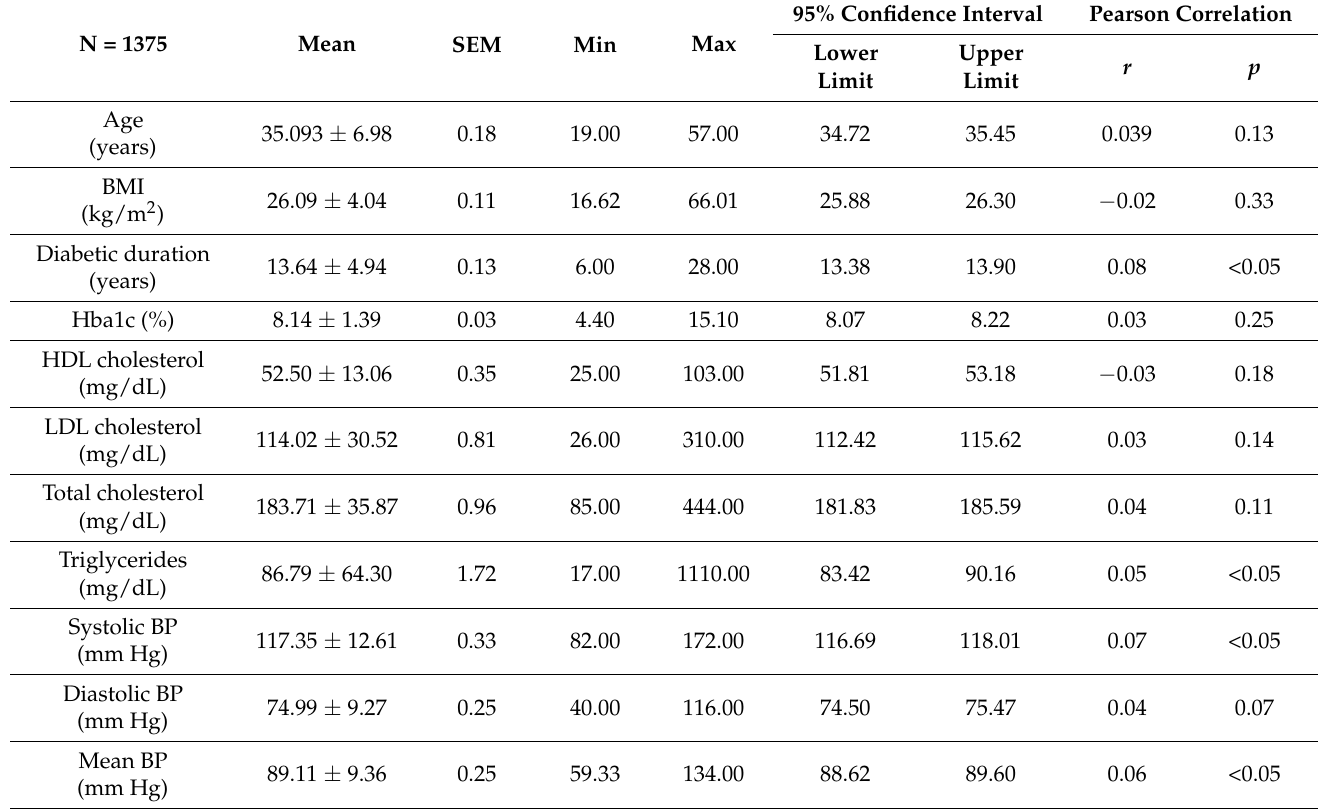
Table 1. Baseline Characteristics of The EDIC Patients (Continuous Features).